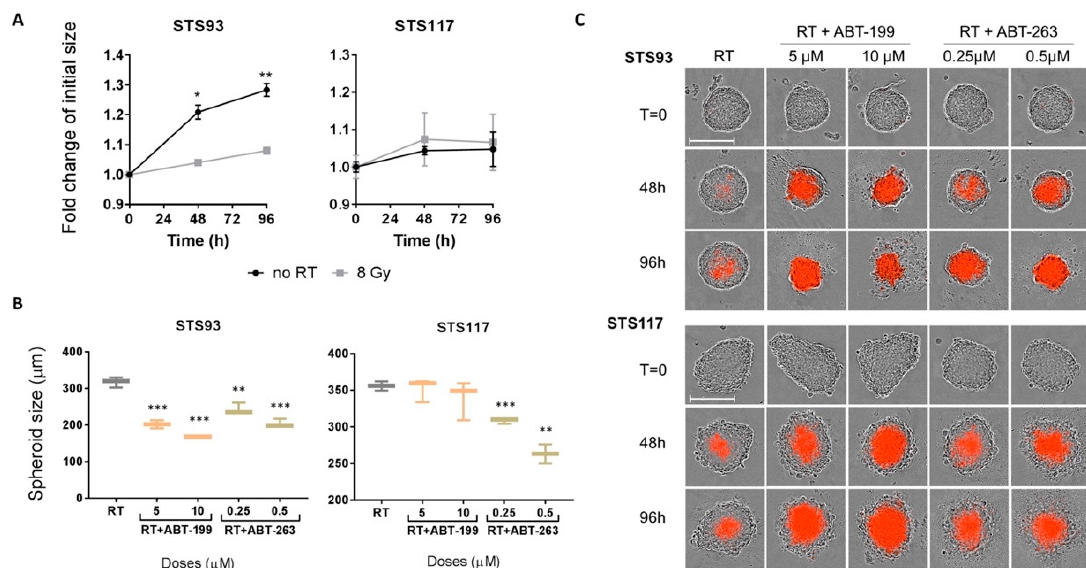
Figure 5. Senolytics can induced cell death in irradiated 3D model of sarcoma cells. ( A ) Fold change in size over time of spheroids untreated or exposed to 8 Gy. ( B ) Size of spheroids irradiated (RT; 8 Gy) or combination of RT and ABT-263 (0.25 µM and 0.5 µM) or ABT-199 (5 µM and 10 µM). Measurements represent size 96 h after treatment. ( C ) Representative pictures of PI incorporation in irradiated spheroids treated with combination treatment over time. T = 0 represents cells prior to drug addition. The scale bar represents 300 µM. Data from ( A ) and ( B ) were analyzed using the two-tail Student’s t-test to compare treatment groups with the control group. * p < 0.05, ** p < 0.01, *** p < 0.001. Data are representative of three experiments. Error bars indicate ± the standard deviation.